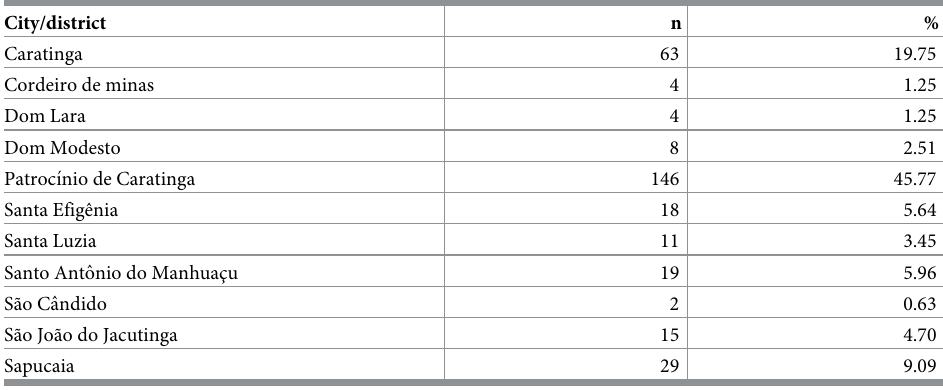
Table 3. Number of ATL cases by city/district during the period from 2007 to 2018.